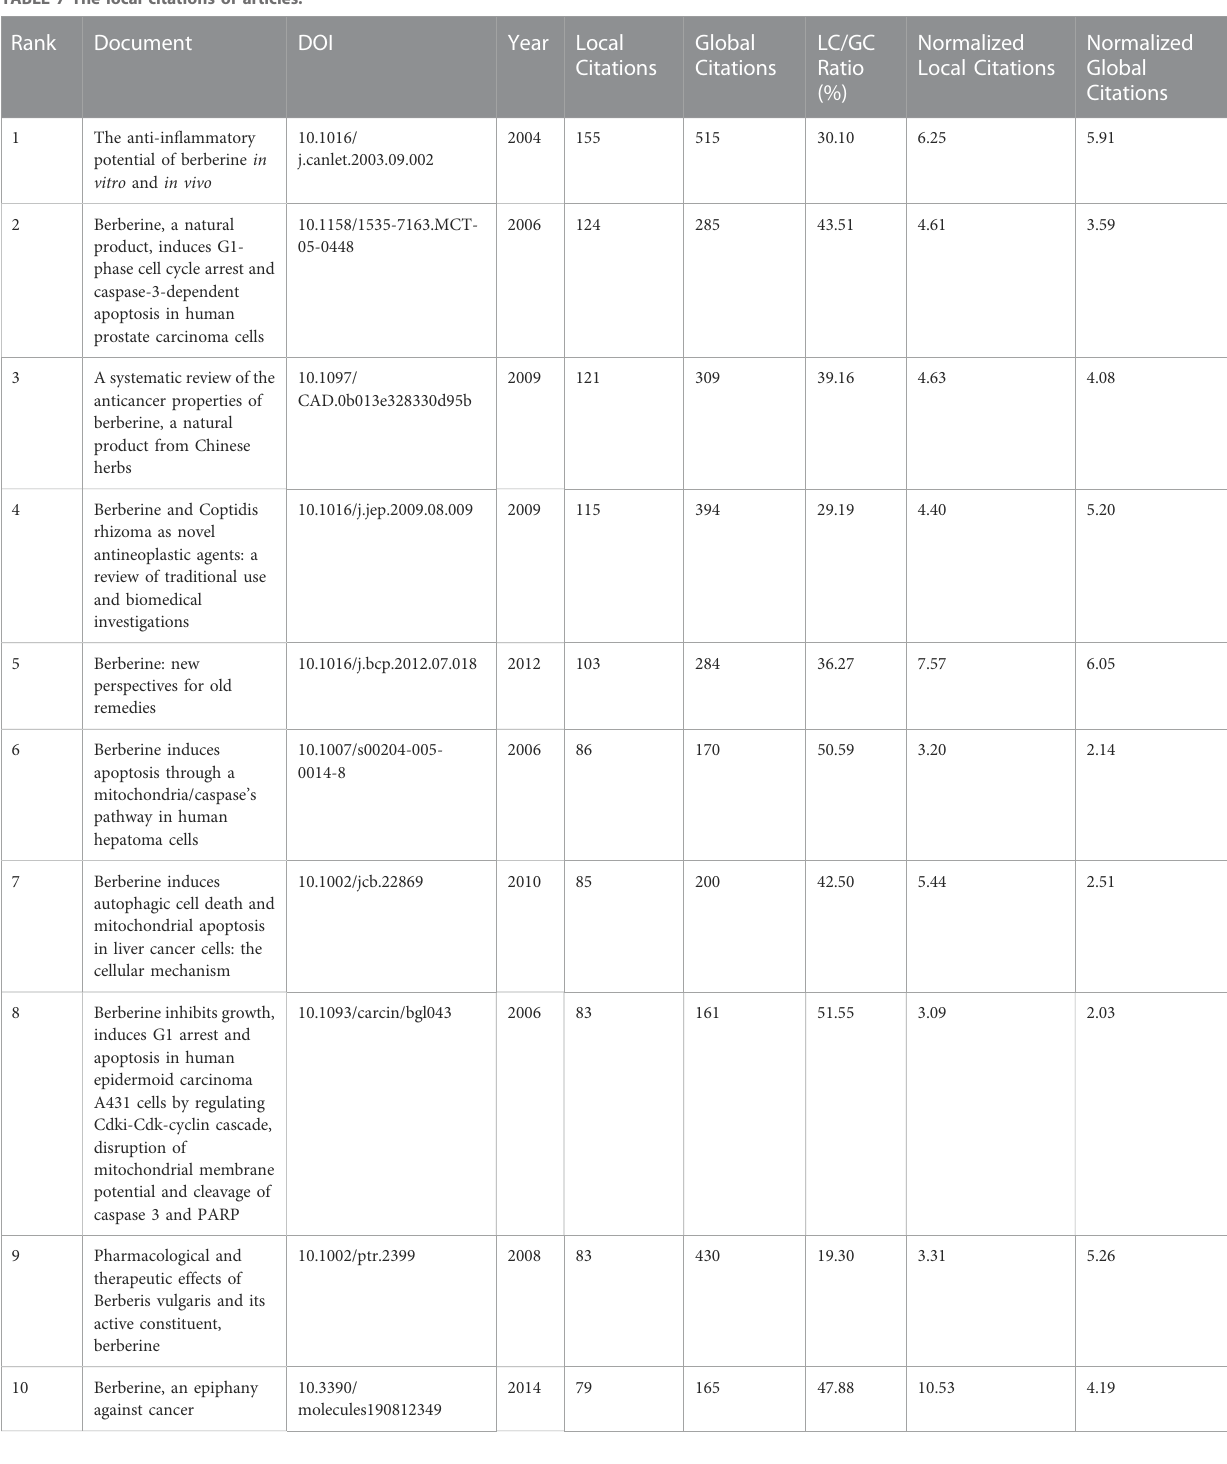
TABLE 7 The local citations of